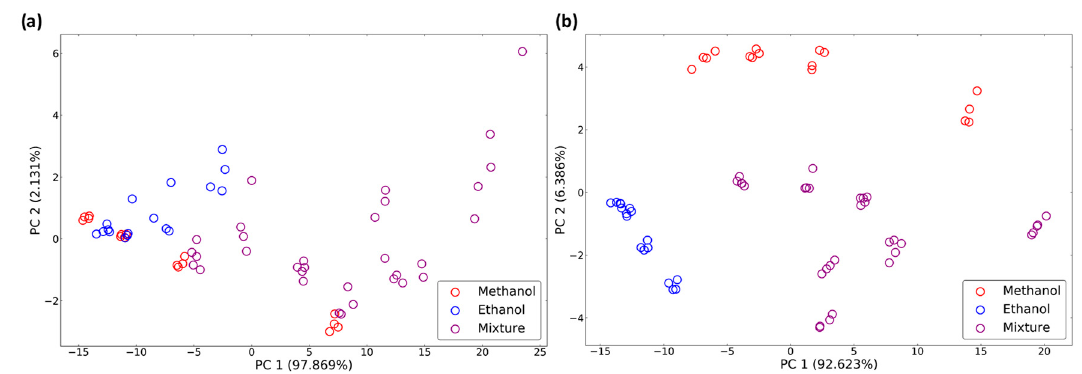
Figure 7. Principle component analysis (PCA) results for data distribution of ( a ) peak features and ( b ) dynamic features.